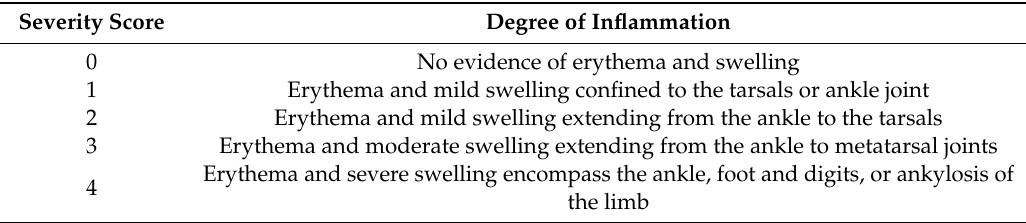
Table 6. Scoring system for the subjective evaluation of arthritis